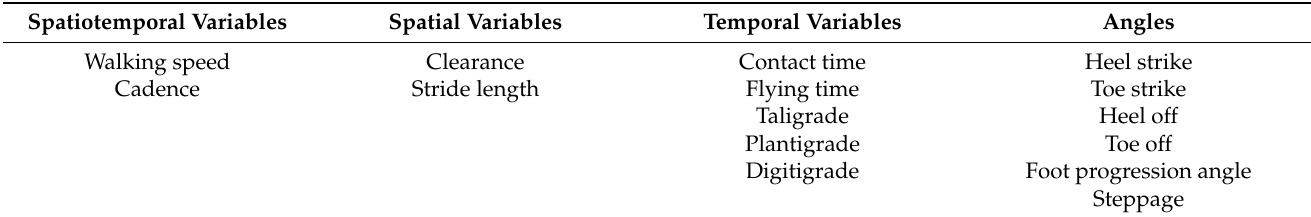
Figure 3. Data recording and transfer procedure. Table 1. Gait analysis variables provided by PODOSmart ®